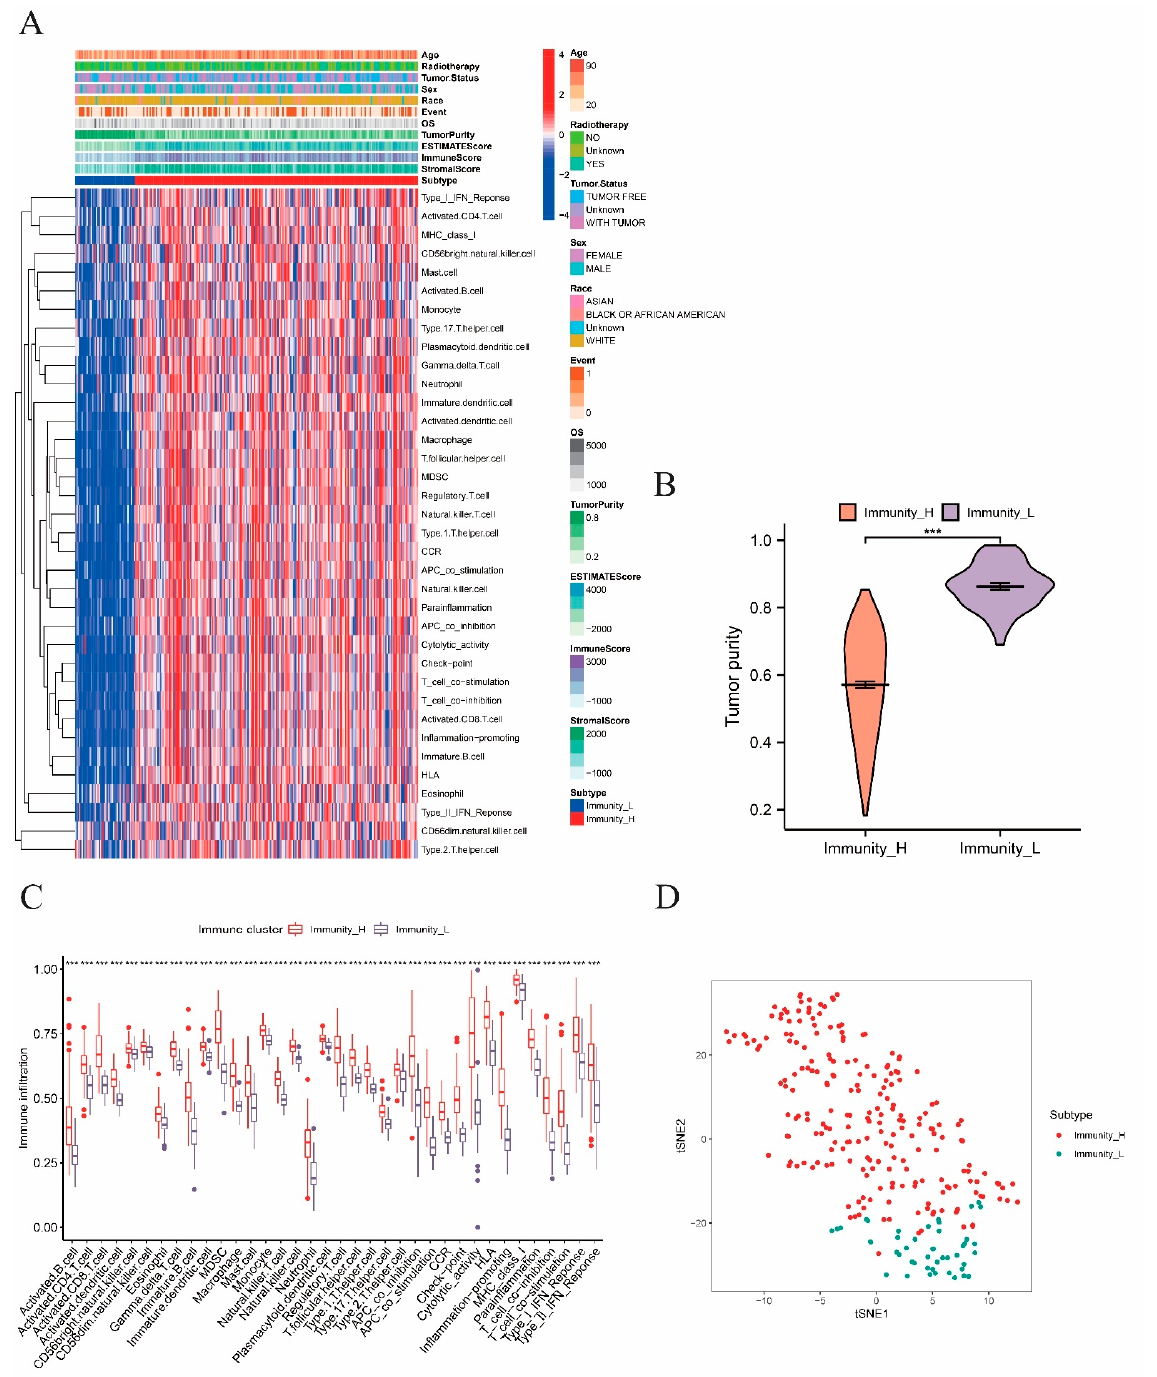
Figure 2. Identification of immune subtypes and differential analysis. The symbols *** represent p -values less than 0.001. ( A ) The ssGSEA analysis performed on the 263 samples to divide the samples into two groups according to 30 ssGSEA scores of each sample. ( B ) Differential analysis on tumor purity score between immunity − high and − low groups. ( C ) Box plot presenting the immune − cell infiltration levels of the immunity − high and − low groups, with the red boxes and blue boxes representing immunity − high and − low groups, respectively. ( D ) The t − SNE analysis on the two immune subtypes, with the red dots and blue dots representing immunity − high and − low groups, respectively.